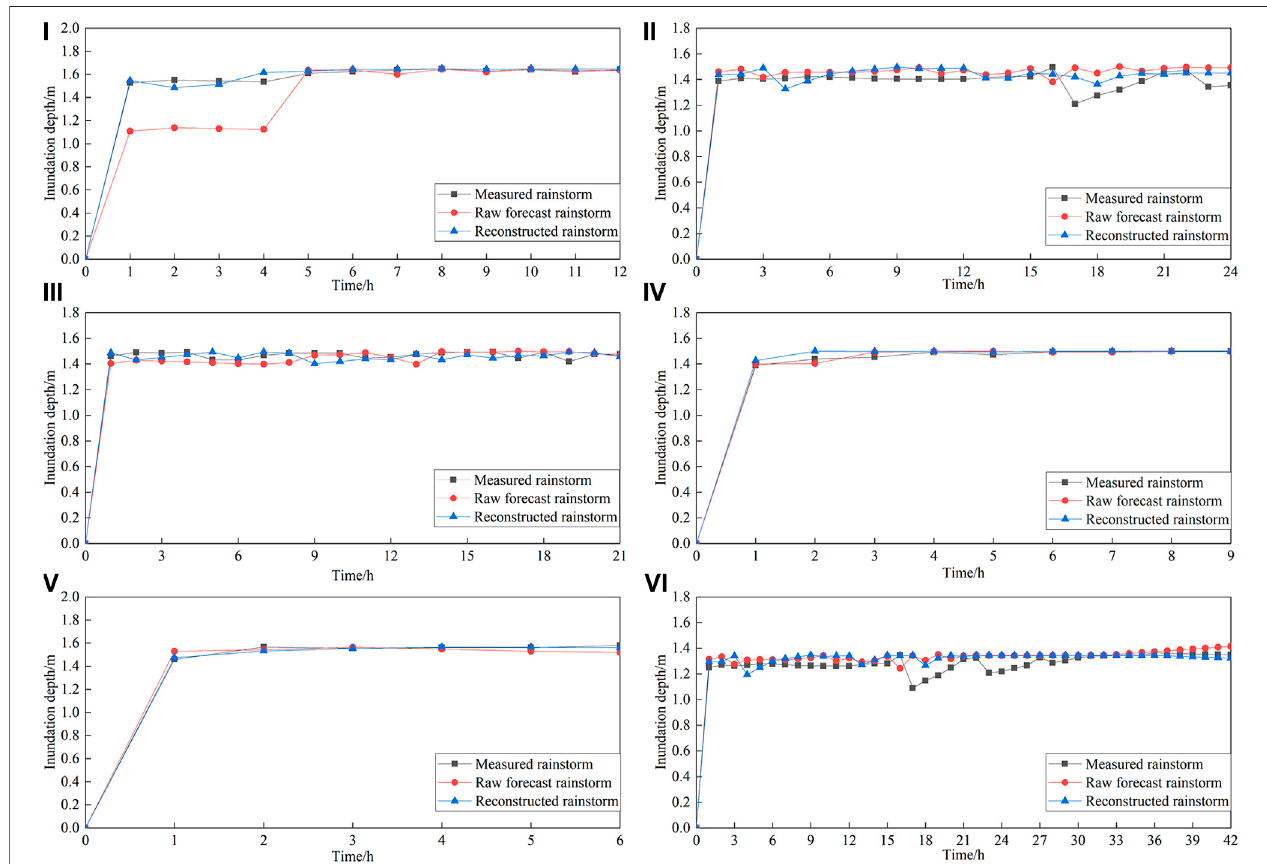
FIGURE 8 | Inundation depth simulation by using different input data: the labels “ I-VI ” represent the serial number of six rainstorms; the black line is the simulated inundationdepthgeneratedbyusingmeasuredrainfalldata;theredlineisthesimulatedinundationdepthgeneratedbyusingtherawGRAPES_MESOforecastdata;the blue line is the simulated inundation depth generated by using the reconstructed forecast data.